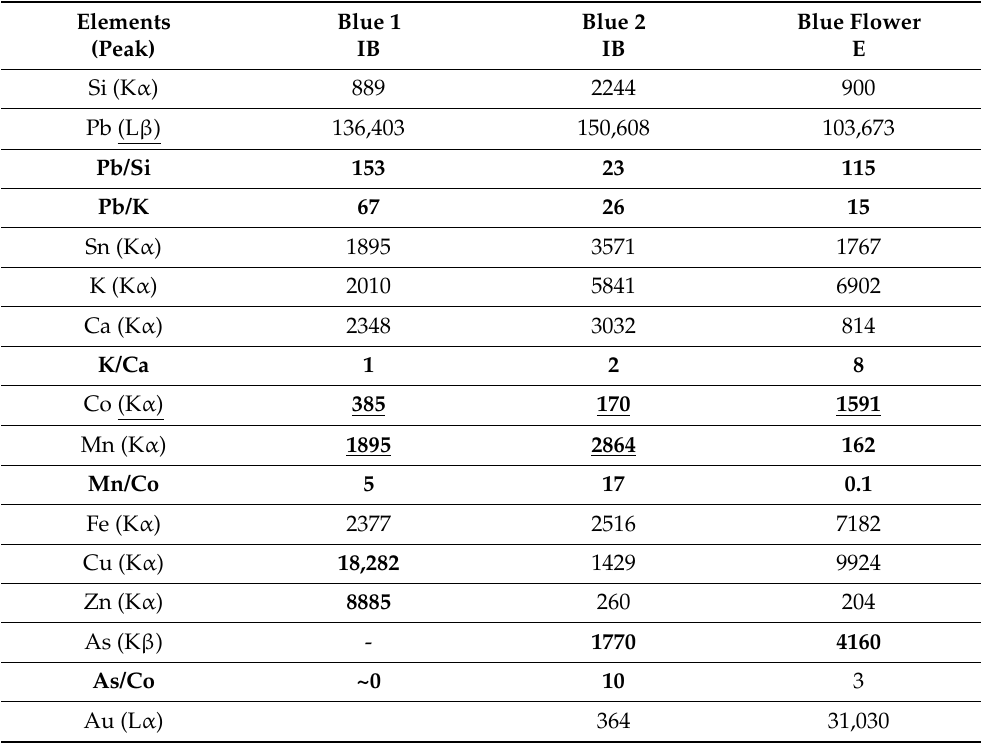
Table 2. Elemental (local) net count areas of characteristic peaks for the blue cloisonn é enameled areas of the incense burner (IB) and ewer (E). Ratios calculated from the net count area. Ions contributing to coloration are in bold (- not calculated). The error deduced from the study of similar heterogeneous objects is less than 15% for major elements but could be 100% for traces.